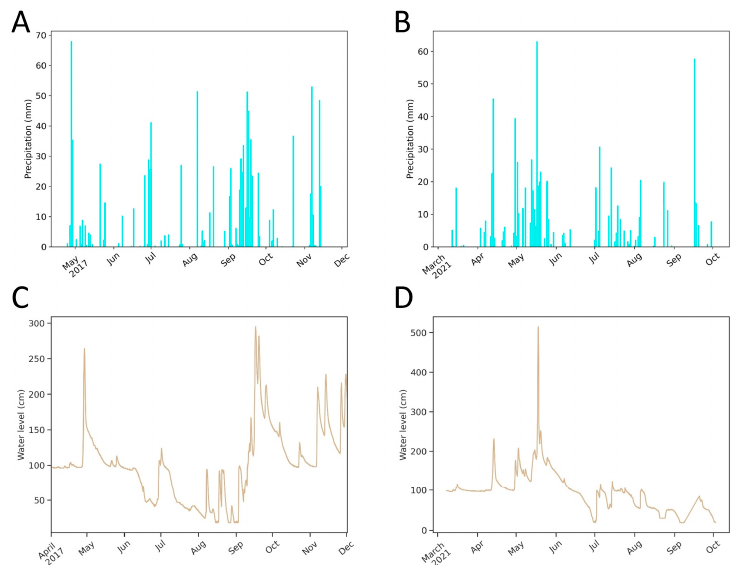
Figure 3. ( A , B ) Precipitation and ( C , D ) water level of the Pivka River in spring–autumn in 2017 and 2021, respectively.